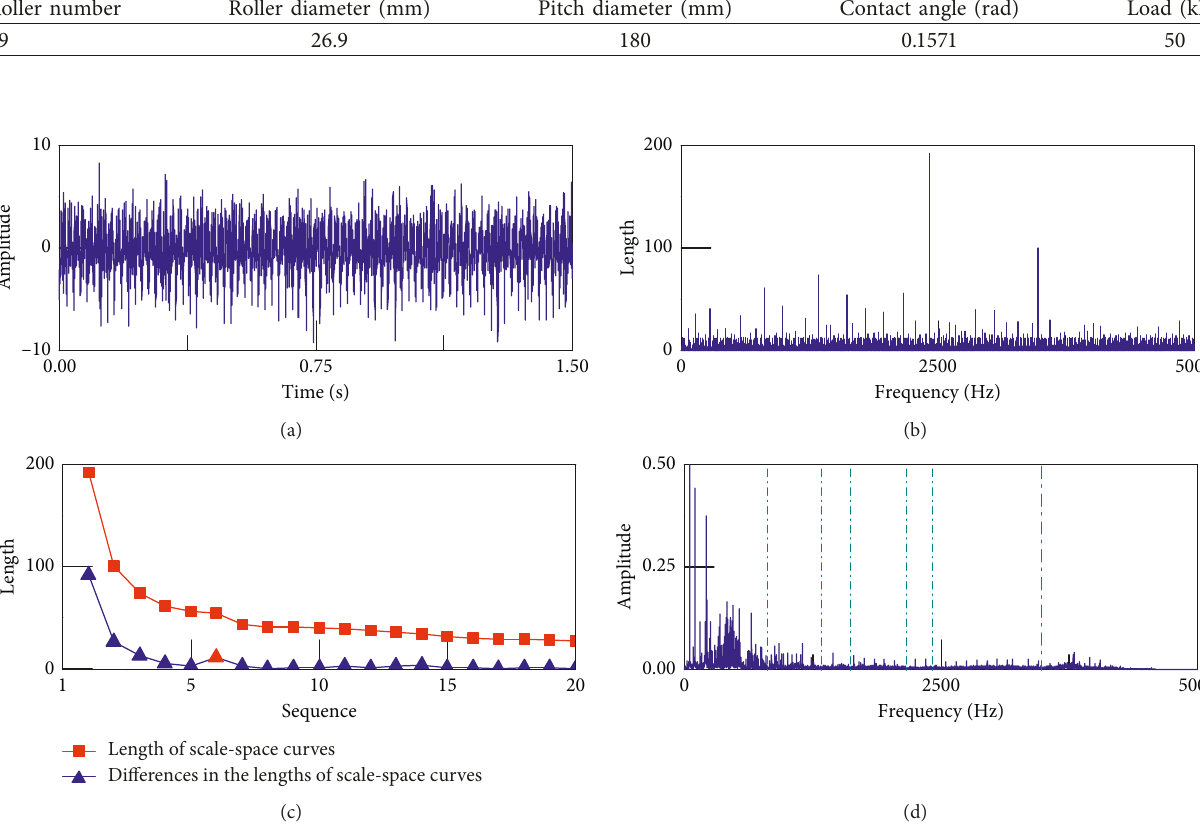
Figure 16: Results obtained by the EWTOSSR method: (a) measured signal; (b) OSSP; (c) differences in the lengths of the scale-space curves; (d) detected boundaries (green dash-dotted